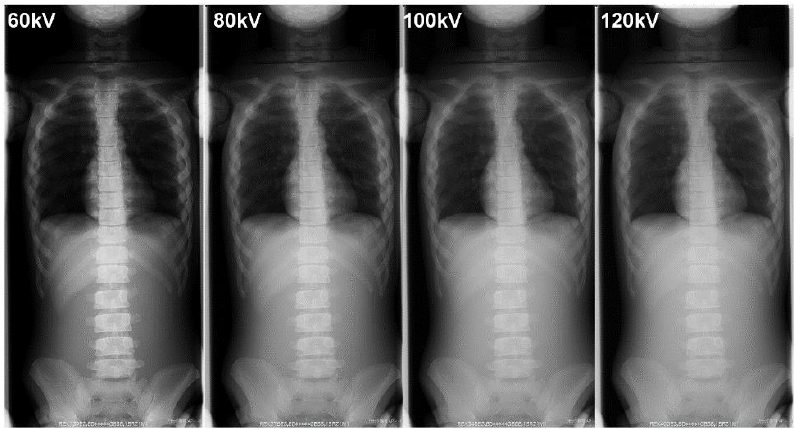
Figure 9. The differences in the phantom image contrast of full-spinal radiographs using various tube voltages (focus-image-receptor distance: 180 cm, with a grid).